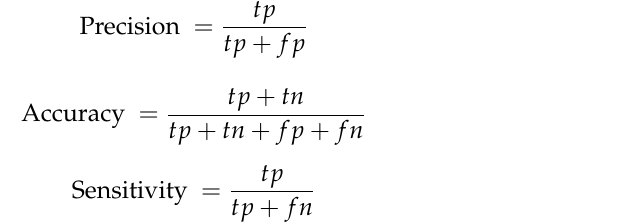
Figure 14. Timing of PCA and raw point number of every second.